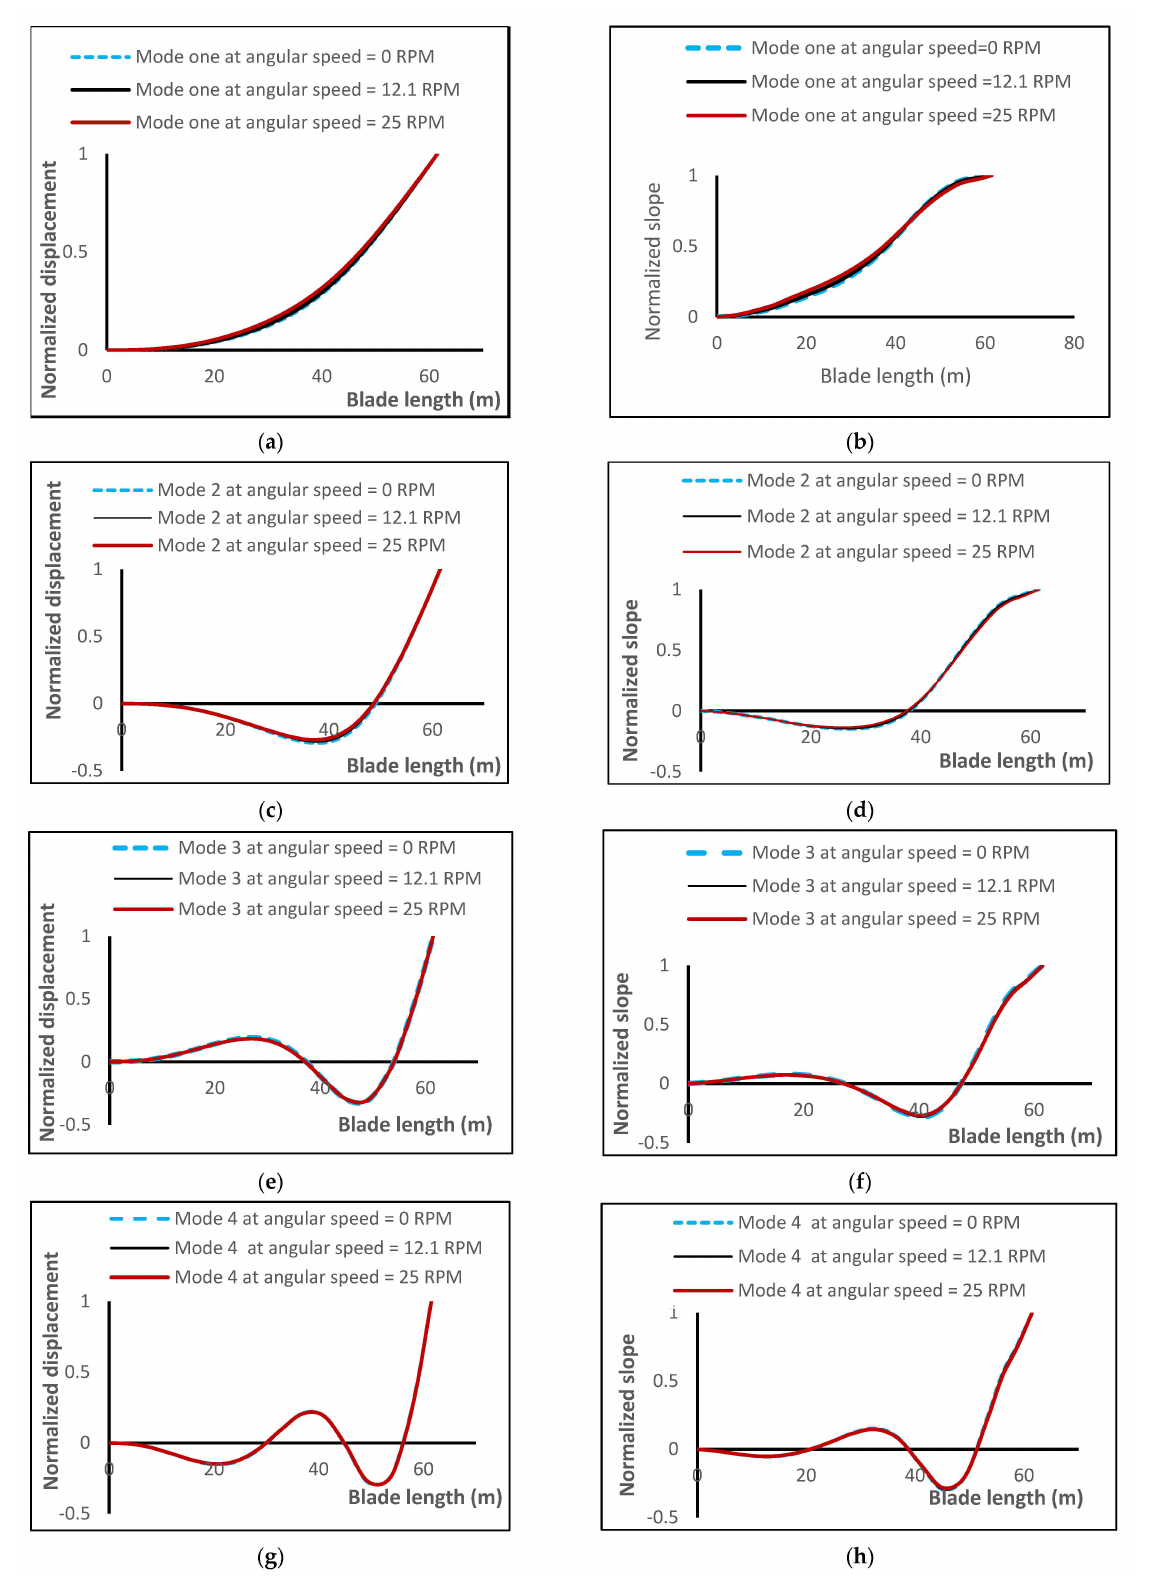
Figure 6. Translational and angular mode shapes of NREL 5 MW HAWT blade at different angular velocities. ( a ) The first translational mode and ( b ) the first angular mode. ( c ) The second translational mode and ( d ) the second angular mode. ( e ) The third translational mode and ( f ) the third angular mode. ( g ) The fourth translational mode and ( h ) the fourth angular